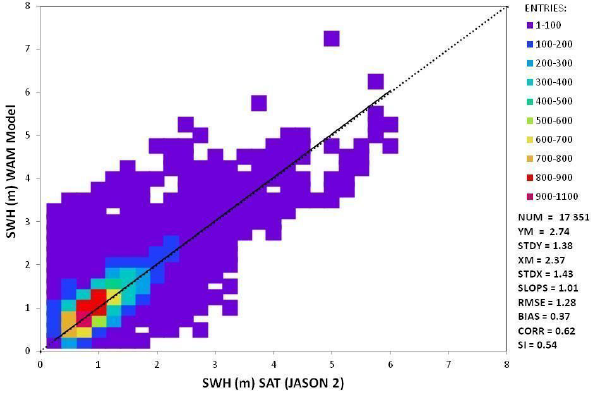
Fig. 3. Scatter diagram of the model significant wave heights vs. the corresponding Jason-2 altimeter data during the period 1 Septem- ber 2010 up to 31 August 2011. The different colours (right scale) represent the numerosity in each box.